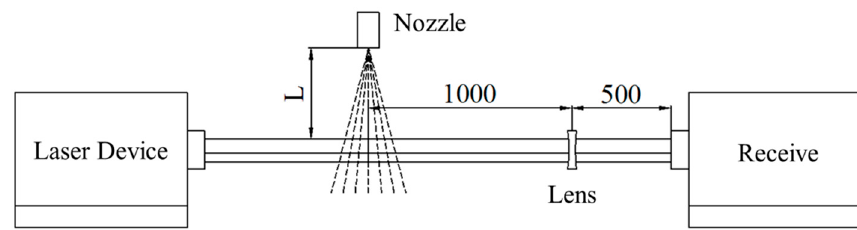
Figure 6. LSA-III Laser particle size tester configurations.